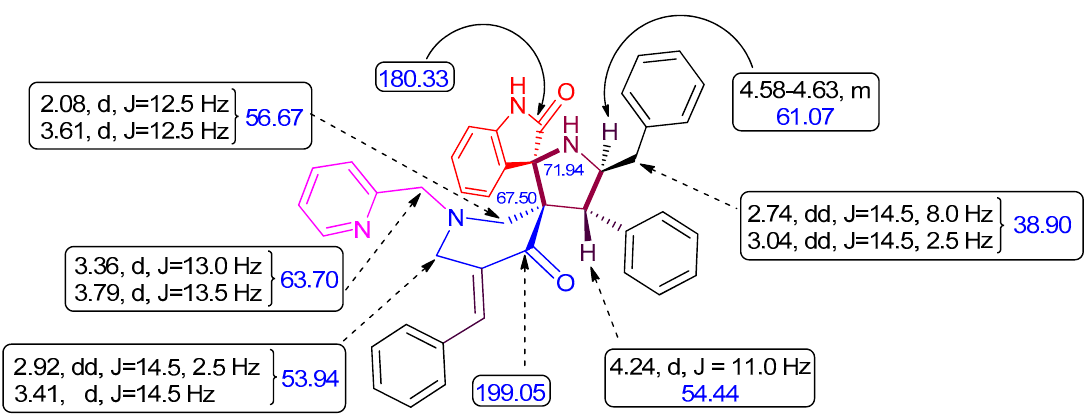
Figure 1. Selected 1 H and 13 C-NMR chemical shifts of 8e.